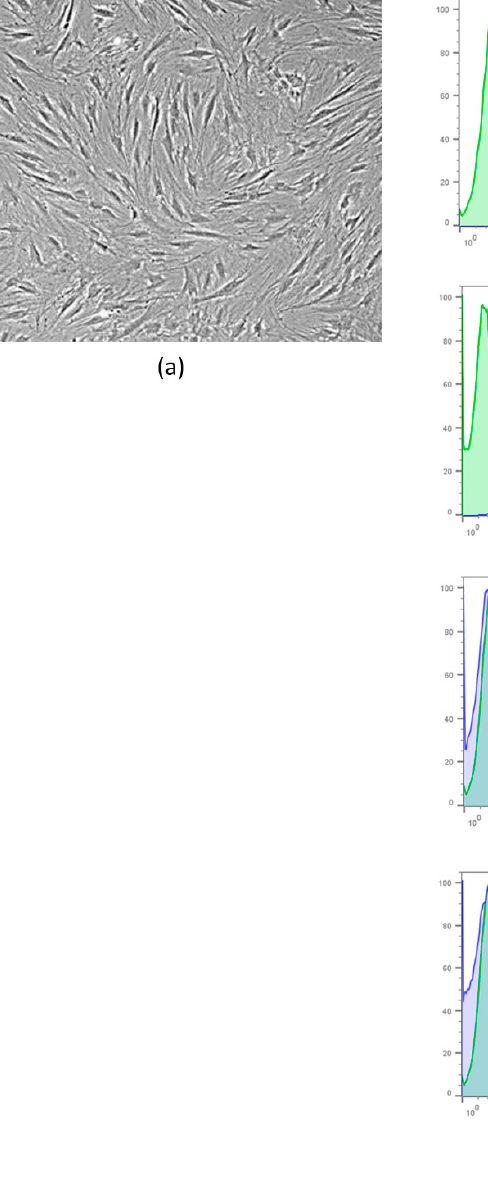
Figure 1. ( a ) MSCs after expansion. ( b ) Immunophenotypic analysis by flow cytometry. Umbilical cord blood-derived mesenchymal stromal cell cord (MSCs-hUCT) characterization (representative set from one donor). The blue histograms indicate the percentage of the population that was positive for each antibody, while the green histograms indicate the isotype controls. For 7-AAD analysis and autologous control was used. Scale bar: 500 µm. The results are expressed as percentages (%).